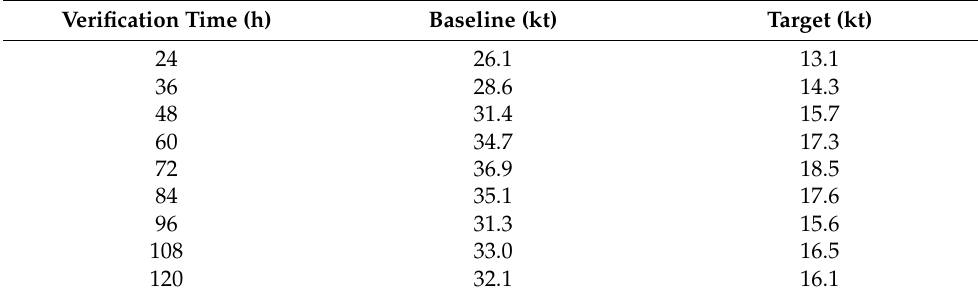
Table 8. HFIP RI performance measure baseline and target errors. Baseline errors are the mean absolute errors over the period 2015–2017 for the Atlantic and eastern North Pacific for the variable consensus, comprising at least two of the models DSHP, LGEM, GHMI, HWFI, and CTCI. Target errors represent 50% of the baseline